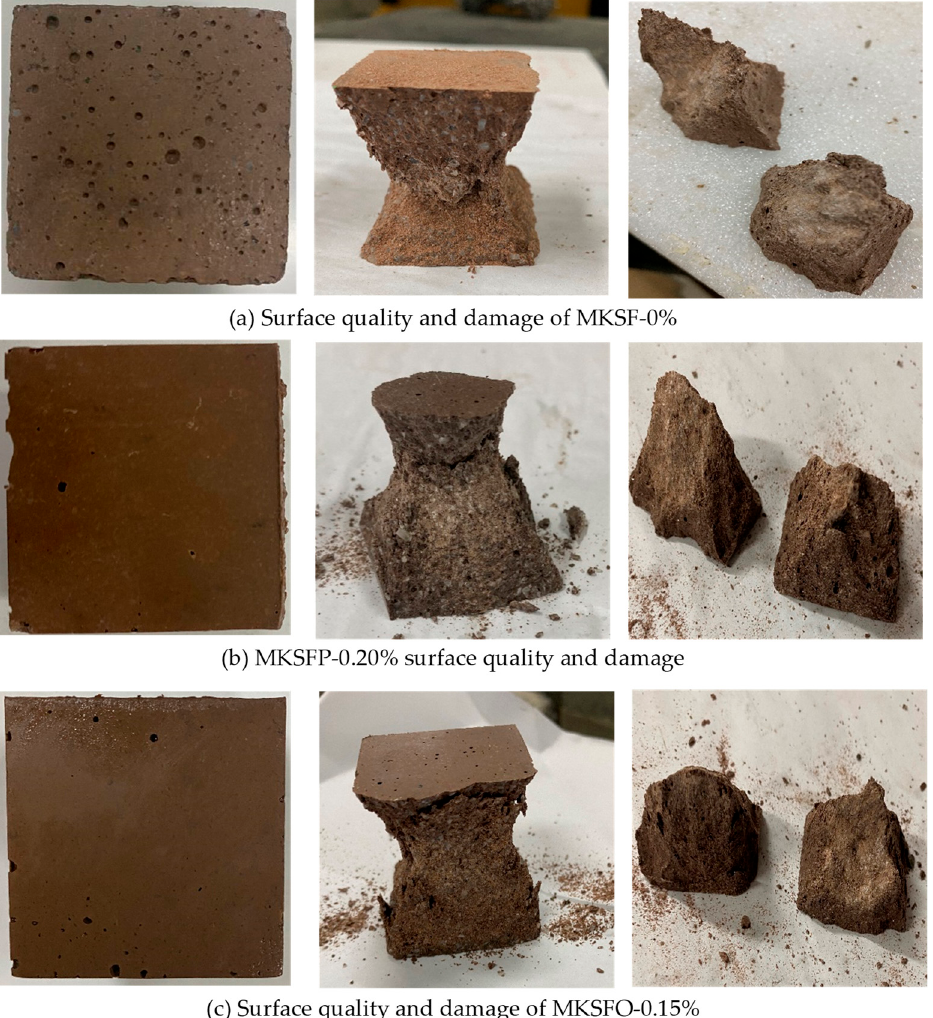
Figure 13. Surface quality and damage with different defoamer dosages.